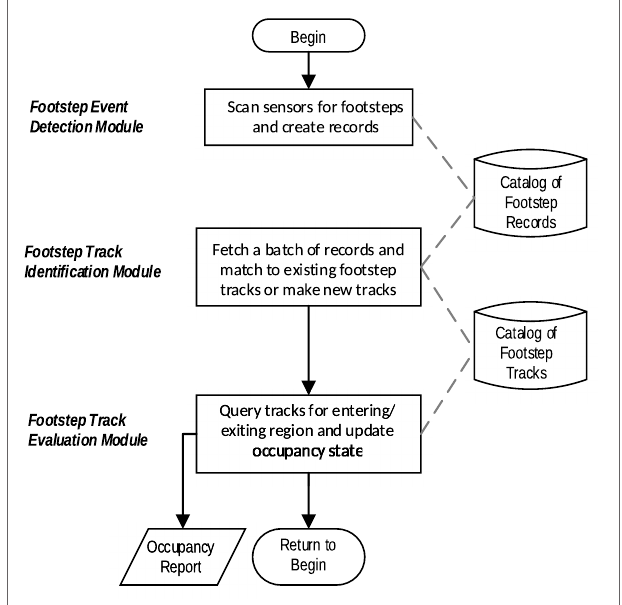
FIGURE 1 | The overall process for converting measurements from vibration sensors to occupancy estimates. The module names on left correspond to the three major processing steps as explained in Sections 2.2–2.4 in greater